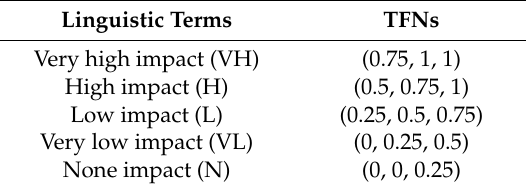
Table 2. Linguistic variables and TFNs to measure influence